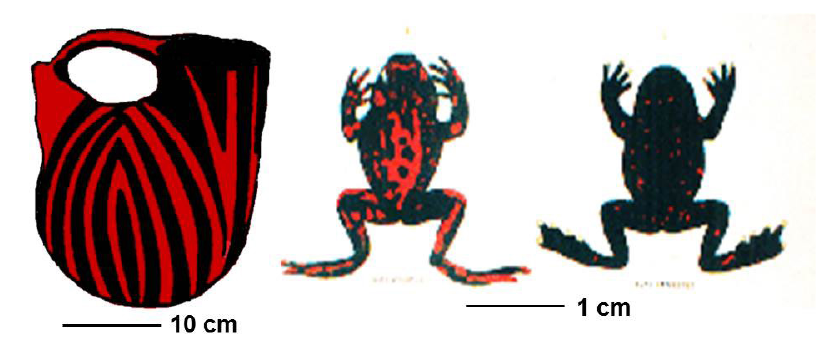
Figure 3. Right: Representation of morphological group 15, “jars”. Left: Front and back illustration of the holotype for Tel- matobufo venustus by Phillipi (1899), published in Formas, Núñez and Brieva (2001, p. 375, Figure 5), with its characteristic aposematic color (red on black).